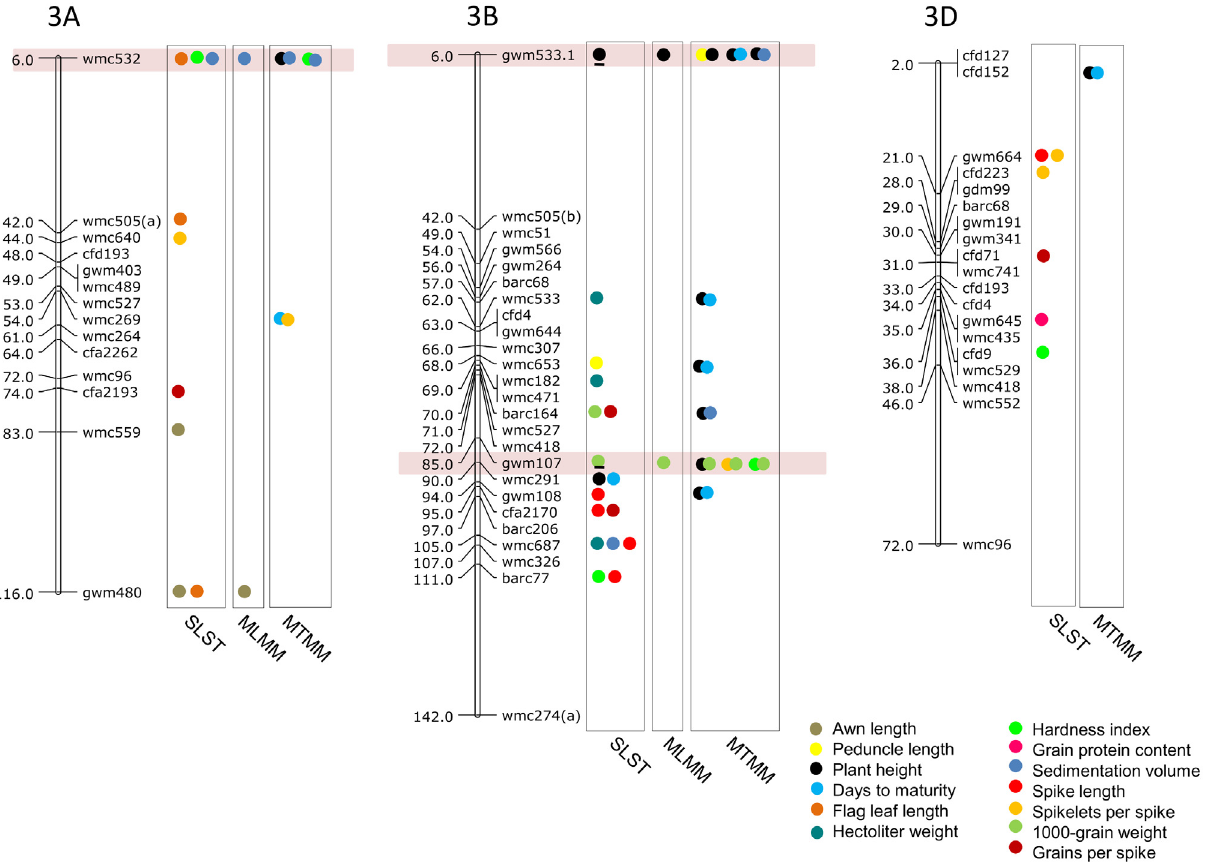
Fig 5. SSR genetic linkage maps of homoeologous group 3 chromosomes showing markers-trait associations (markers associated with different traits are shown by solid circles with different colours), black bar given below the solid circle represents that MTA qualified FDR criterion; markers are indicated to the right and map distances (cM) are indicated to the left of the vertical bar (based on the consensus linkage map of Somers et al. [76]. MTAs identified through all three approaches (SLST, MLMM and MTMM) are highlighted with